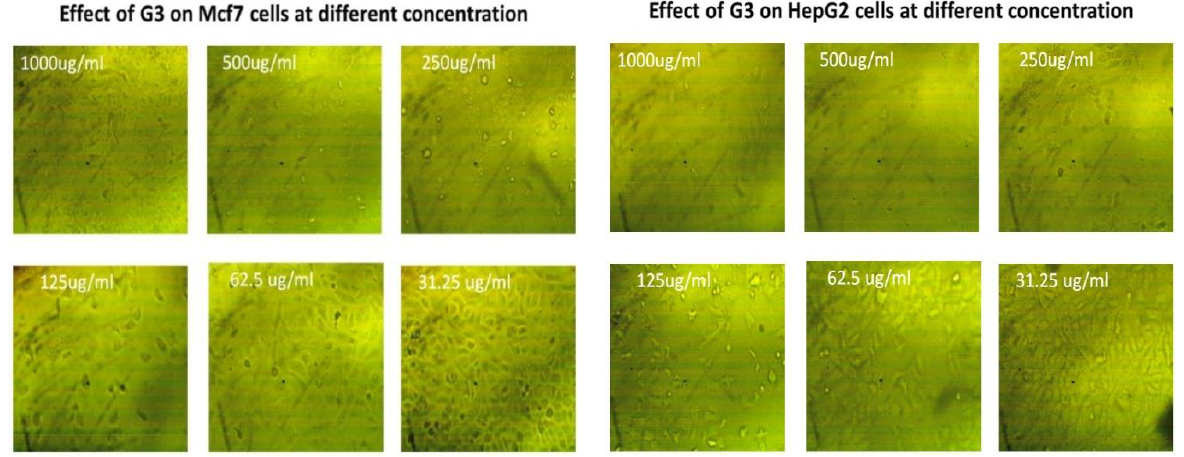
Figure 9. The morphologies of MCF-7 cells ( left ) and HepG2 cells ( Right ) were treated with G3-D9-Asp for 72 h. Images were acquired using a microscope (200× magnification).